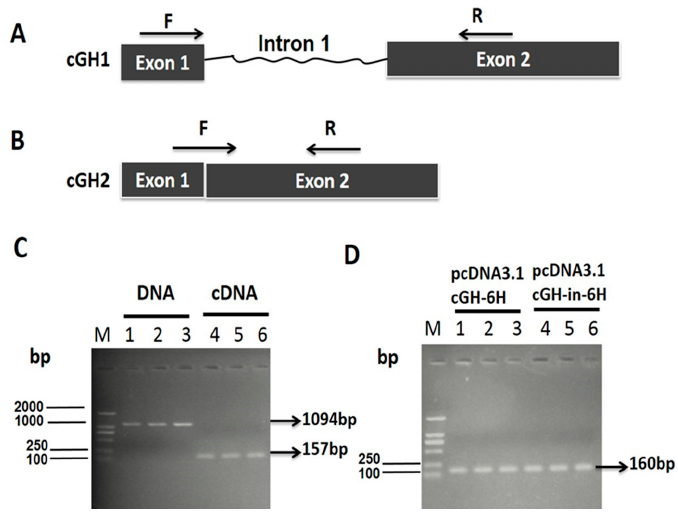
Figure 1. PCR product confirms the correct splicing of chicken growth hormone ( cGH ) intron 1 in GH4-C1 cell lines at 48 h post-transfection with pcDNA3.1cGH-6H or pcDNA3.1cGH-in-6H. ( A ) A schematic diagram showing the position of cGH1 primers in cGH , which are depicted by arrows. The forward primer (F) was located on exon 1, and the reverse primer (R) was located on exon 2; ( B ) a schematic diagram showing the position of cGH2 primers in the cGH , which are depicted by arrows. The forward primer (F) was located at the junction of exon 1 and exon 2, and the reverse primer (R) was located on exon 2; ( C ) an electrophoresis map showing the PCR product generated from the GH4-C1 cell lines post-transfection with pcDNA3.1cGH-in-6H. cGH1-F and cGH1-R were used as the primers, which are depicted in ( A ). DNA or cDNA from the GH4-C1 was used as a template, marked by the white bold characters; ( D ) an electrophoresis map showing PCR products generated from the GH4-C1 post-transfection with pcDNA3.1-cGH-6H or pcDNA3.1-cGH-in-6H. cGH2-F and cGH2-R were used as the primers, as depicted in ( B ). The temples were cell cDNA from the GH4-C1 transfected with pcDNA3.1-cGH-6H or pcDNA3.1-cGH-in-6H, which are marked by black bold characters. The lanes show the cell samples chosen at random from the GH4-C1 in ( C , D ) .